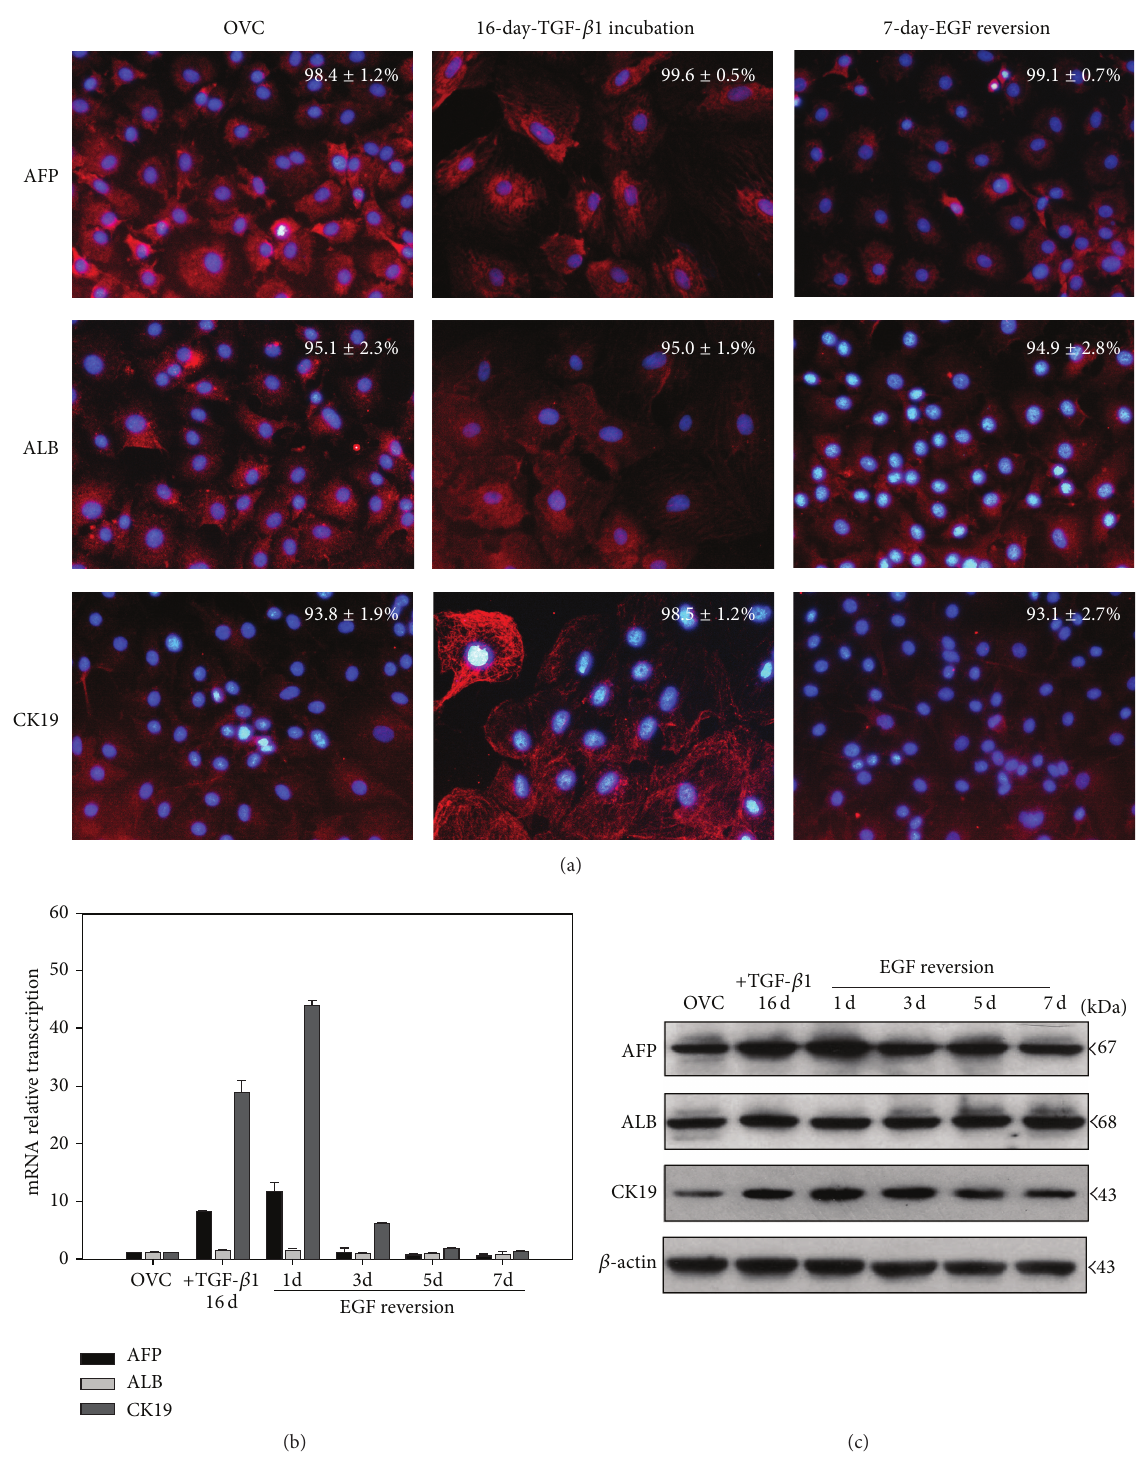
Figure 2: Hepatic oval cells maintained their progenitor immunophenotype in the EMT/MET process. (a) Hepatic oval cells expressed AFP, ALB, and CK19 after 16-day TGF- 𝛽 1 incubation and 7-day EGF-reversion cells. (b) Real-time PCR analysis showed that 16-day TGF- 𝛽 1 incubation increased AFP and CK19 transcription of hepatic oval cells, while EGF time-dependently reduced AFP and CK19 transcription to the level of control cells at 7 d. ALB transcription did not change during the EMT/MET process. (c) Western blot analysis also showed that TGF- 𝛽 1 increase AFP and CK19 expression, whereas EGF downregulated AFP and CK19 expression in a time-dependent manner. ALB expression also did not change during EMT/MET